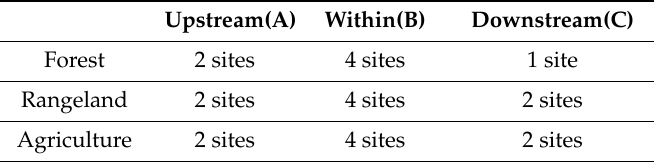
Table 3. Site distribution according to land use (soil texture at all sites is clay